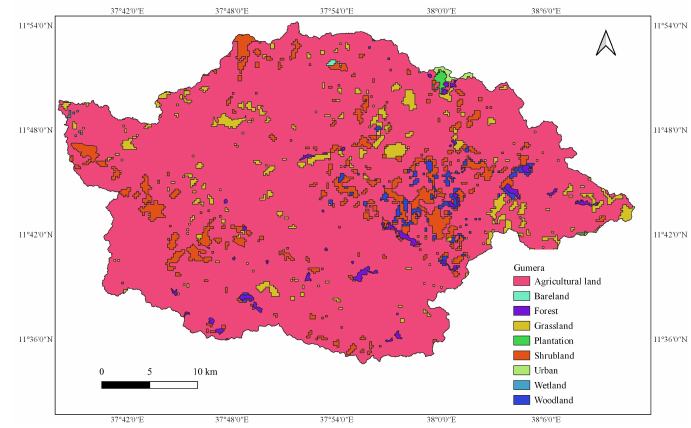
Figure A9. Land use map of Gumera Watershed from 2010 to 2015.